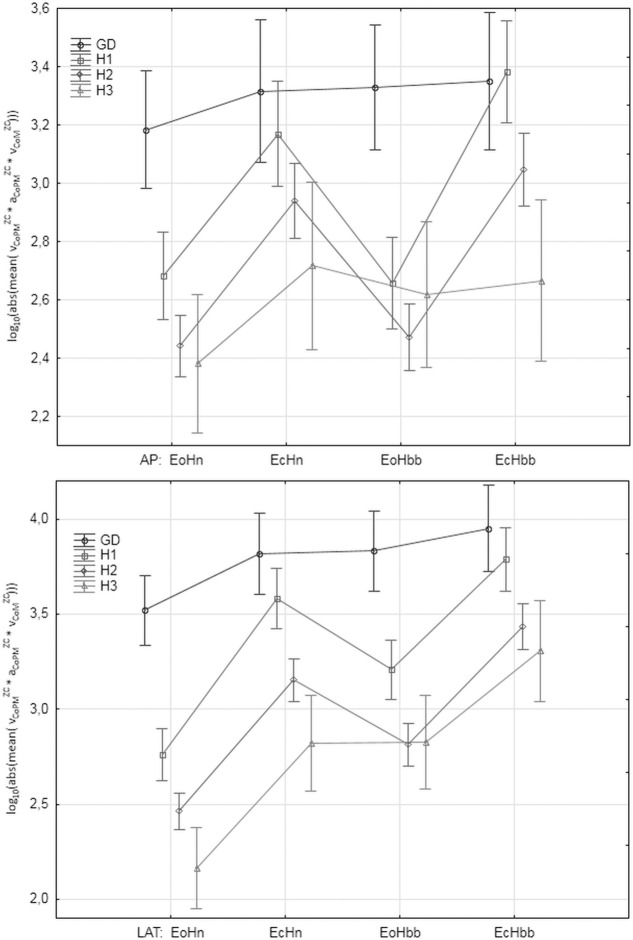
The mean values of LM = log10 (|mean(vCoPMZC· vCoMZC· aCoPMZC)| ) in the subsequent patients and registration condition groups.LM represents the simple function of all the analyzed Zero-Crossing derived parameters. Upper: antero-posterior (AP), bottom: lateral (LAT) component of the signal. Markers denote the standard error of the mean.